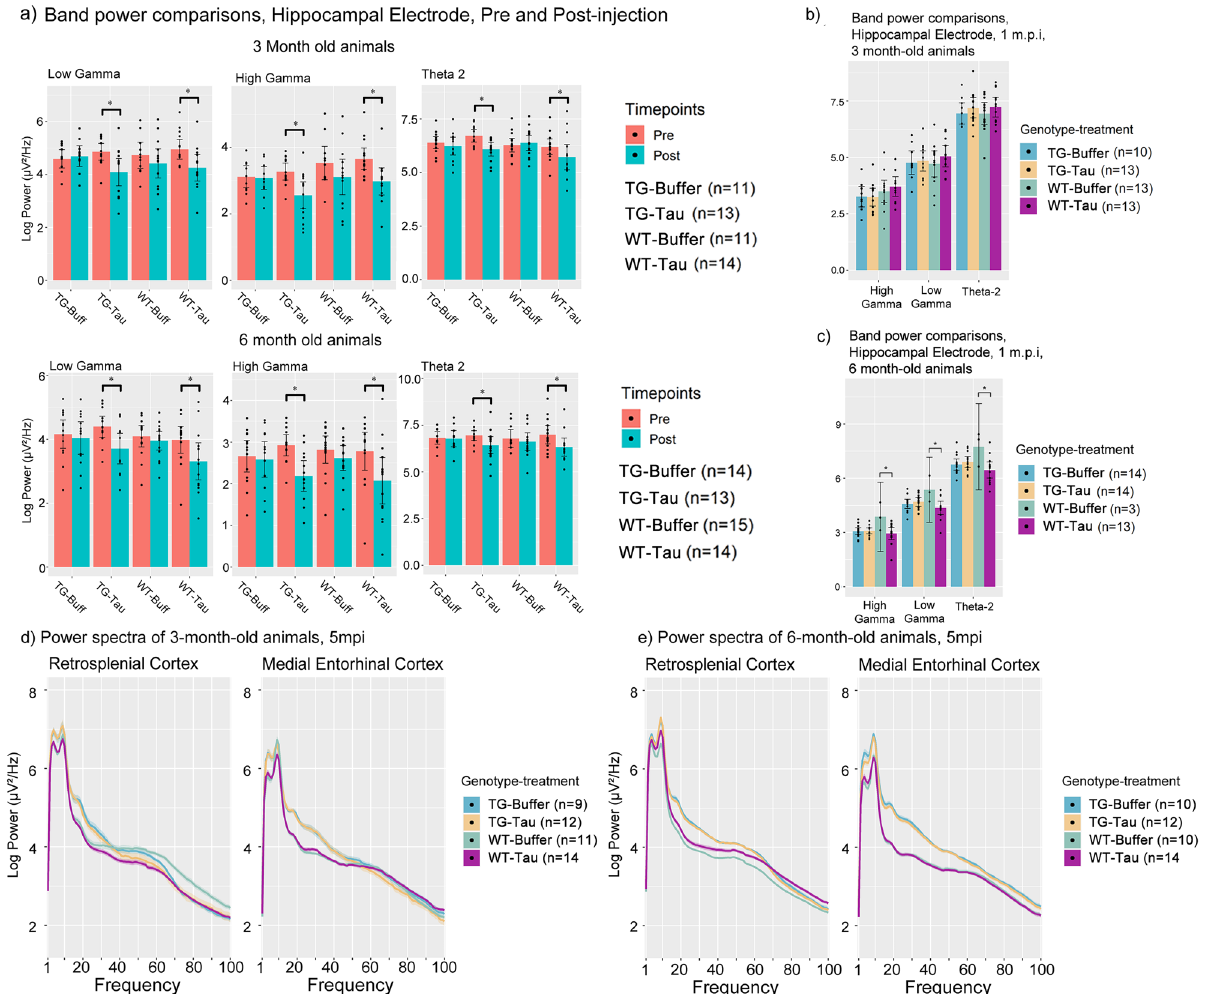
Low and High Gamma power at Pre-injection (Pre) and Post-injection (Post). ( b ) Bar plot comparisons of 3-month-old animals for each of the bands investigated for pre- and post-injection changes in power spectra at 1 m.p.i. ( c ) Bar plot comparisons of 6-month-old animals for each of the bands investigated for pre- and post- injection changes in power spectra at 1 m.p.i. (Due to the impact of Covid-19 lockdowns, several datapoints from the 6-month-old 1 m.p.i. timepoint for WT- Buffer group could not be obtained, thus resulting in n = 3). Log Power spectra from 1 to 100 Hz of the retrosplenial cortex of ( d ) 3-month-old animals and ( e ) 6-month- old animals at 5 months post injection. (m.p.i. refers to months post injection). All bar plots are Mean + SEM. Asterisks indicate significant comparisons ( p <